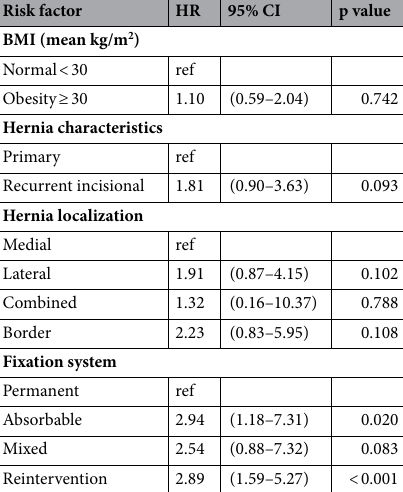
Type of fixation